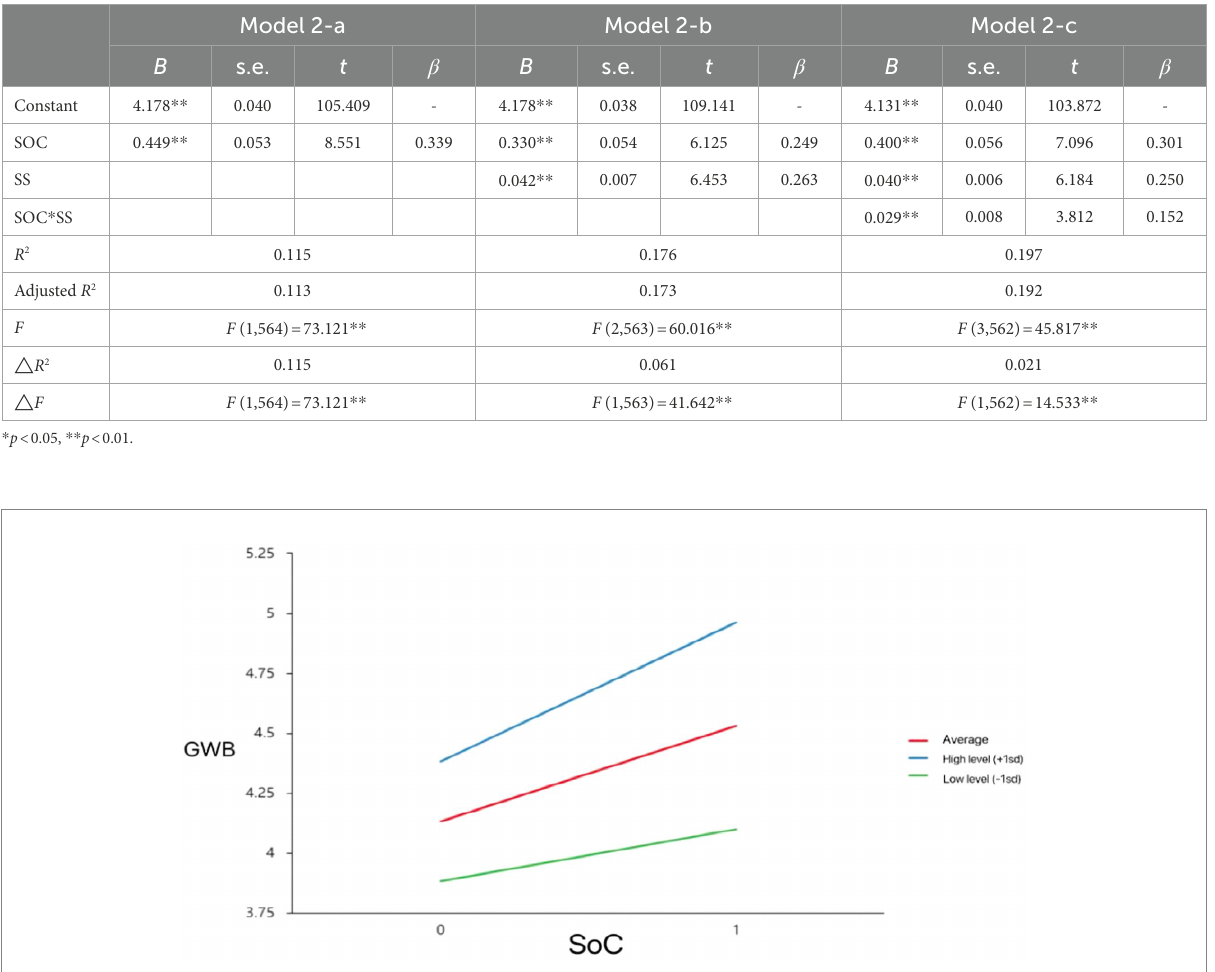
TABLE 5 Sense of community and general well-being: moderating roles of social support.